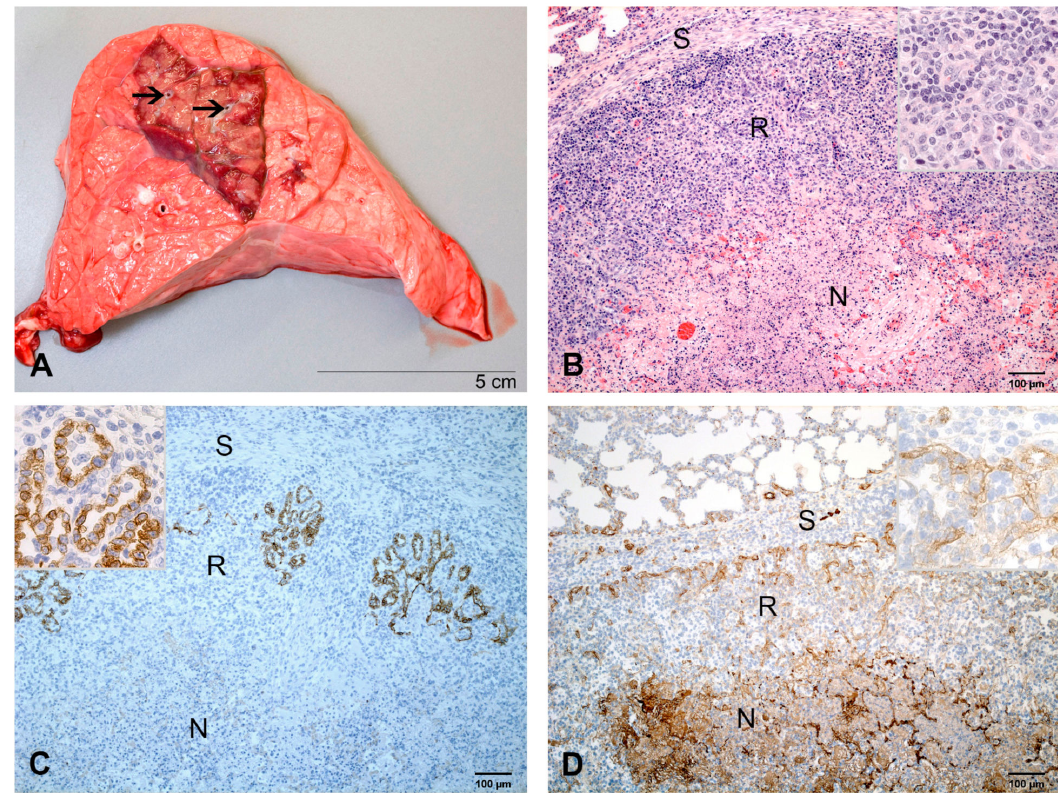
Figure 6. Pulmonary lesions at 10 dpi. ( A ) Section through a basal lobe. The greyish lesion centered round a bronchus (arrow) is demarcated by hyperemia. ( B ) A broad zone of regeneration (R) with multifocal epithelial proliferates surrounds the necrosis (N). Infiltrates of macrophages, lymphocytes and plasma cells are especially prominent next to the interlobular septum (S). Inset: higher magnification of the zone of regeneration. HE-stain. ( C ) Multiple foci of epithelial proliferates (brown) in the zone of regeneration (R) form alveolar structures lined with cuboidal cells. Inset: higher magnification cuboidal epithelial cells. IHC, cytokeratin. ( D ) Capillaries (brown) originating from the interlobular septum (S) pass into the zone of regeneration (R). Fibrinous exudate (brown) is present within the necrosis (N). Inset: higher magnification of capillaries. IHC, factor